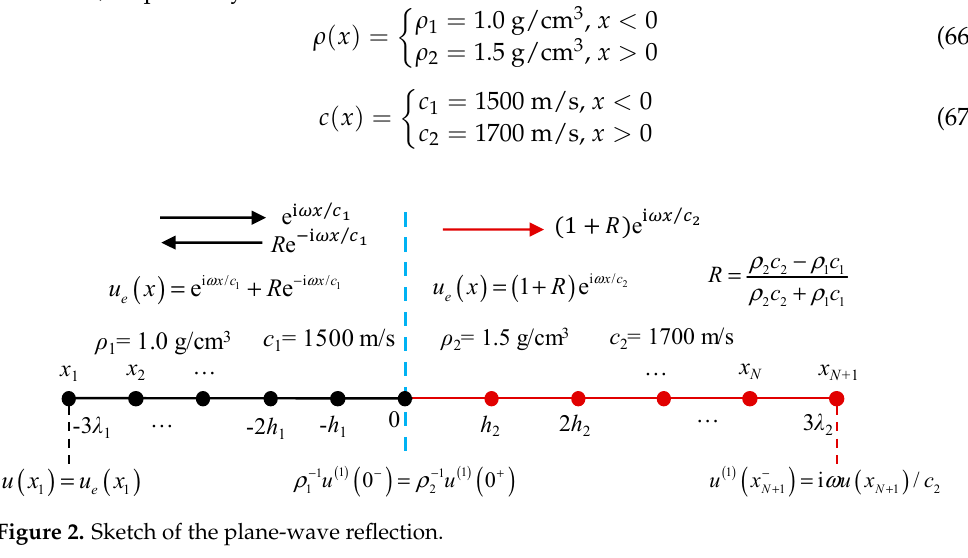
Figure 2. Sketch of the plane-wave reflection.